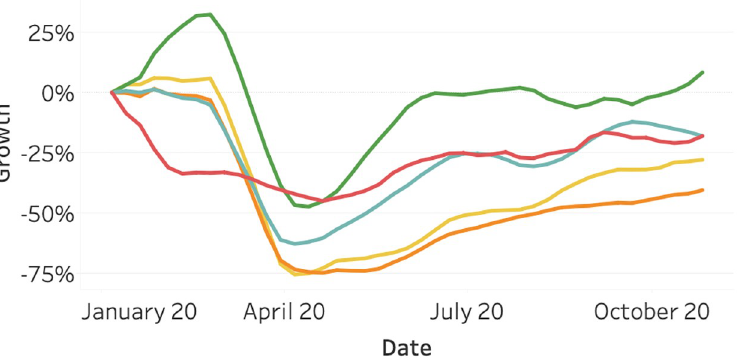
Fig 3. Vehicle activity as of January 2020, split per continent. North America (orange), South America (yellow), Asia (red), Europe (light blue), and Oceania (green).